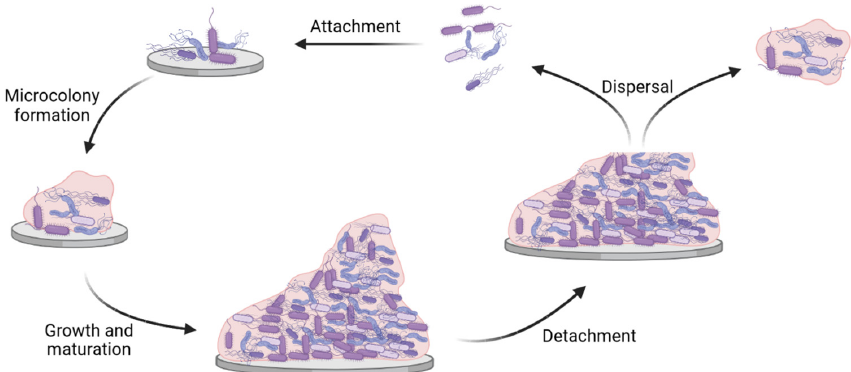
Figure 1. Schematic representation of the formation and dispersal of bacterial biofilm. Attachment represents the initial phase of biofilm growth, during which planktonic bacteria bind to an abiotic or biotic surface. Thereafter, microcolonies are formed when irreversibly adhered bacteria grow as a multicellular community. Proliferation and secretion of extracellular matrix components leads to the growth and maturation of the biofilm. Finally, detachment and dispersal of biofilms results in the release of both planktonic and microcolonies to the environment.